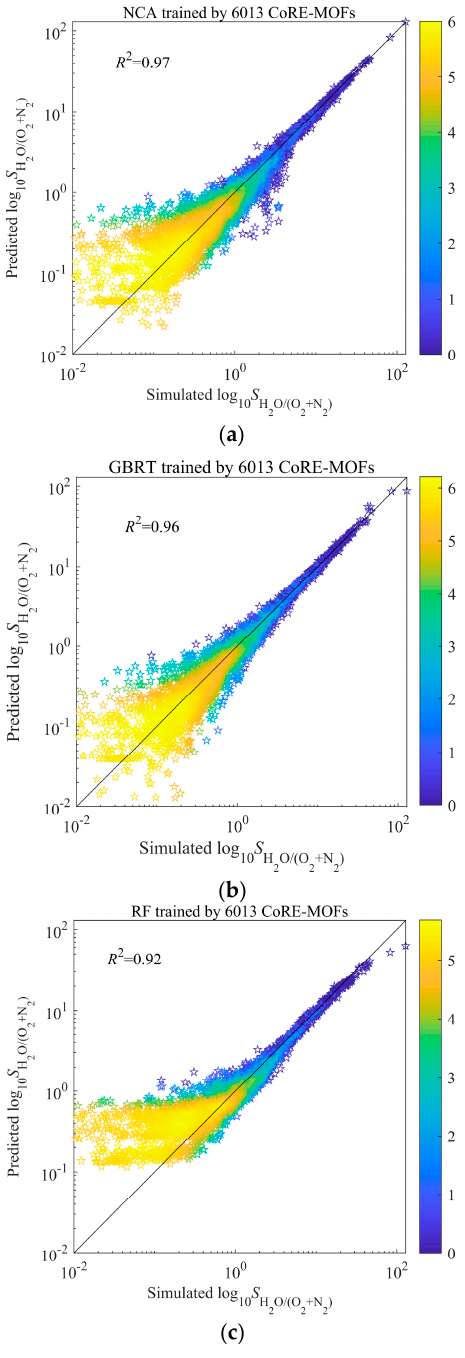
Figure 3. Model ( a ) NCA, ( b ) GBRT, and ( c ) RF trained by 6013 CoRE-MOFs. The color represents a base- e logarithm of the number of MOFs.